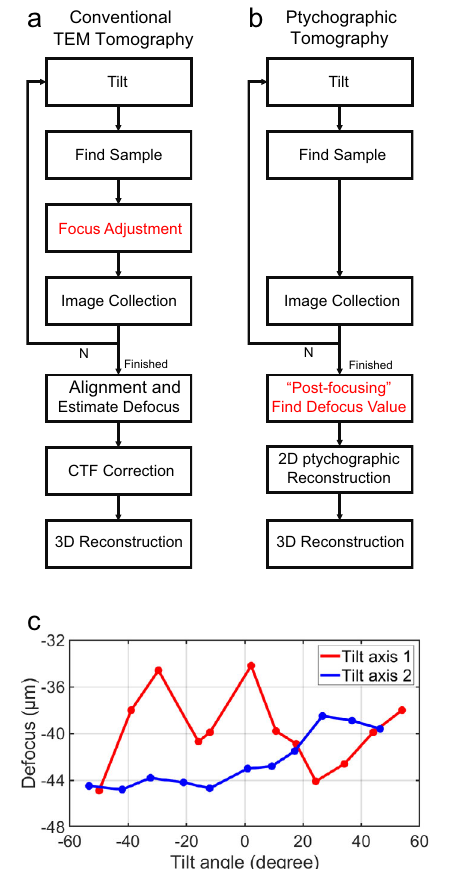
Fig. 5 | Work fl ows for tomography and post-acquisition correctionofdefocus. Work fl ows for tomography based on TEM images ( a ) and ptychography ( b ). c Defocus variations corrected by post-acquisition defocus adjustment as a func- tion of tilt